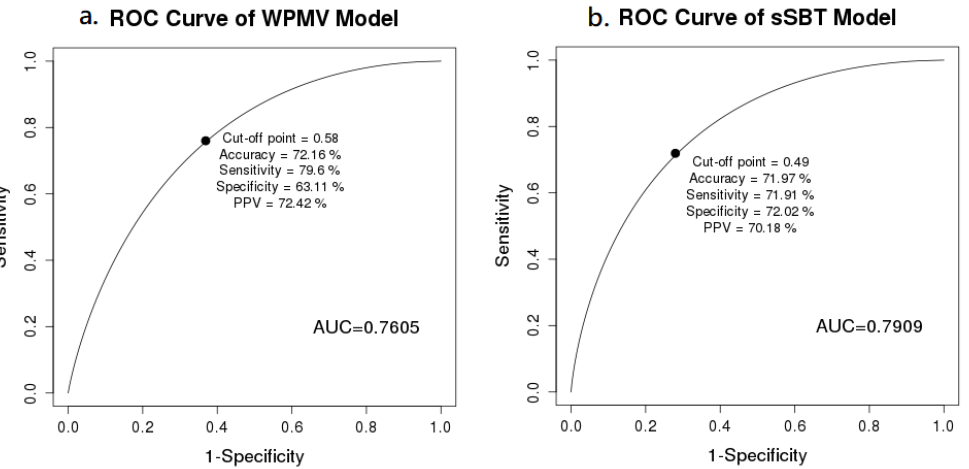
Figure 2. Receiver operating characteristic curve of the weaning probability of mandatory ventila- tion prediction model ( a ) and successful spontaneous breathing trial prediction model ( b ).